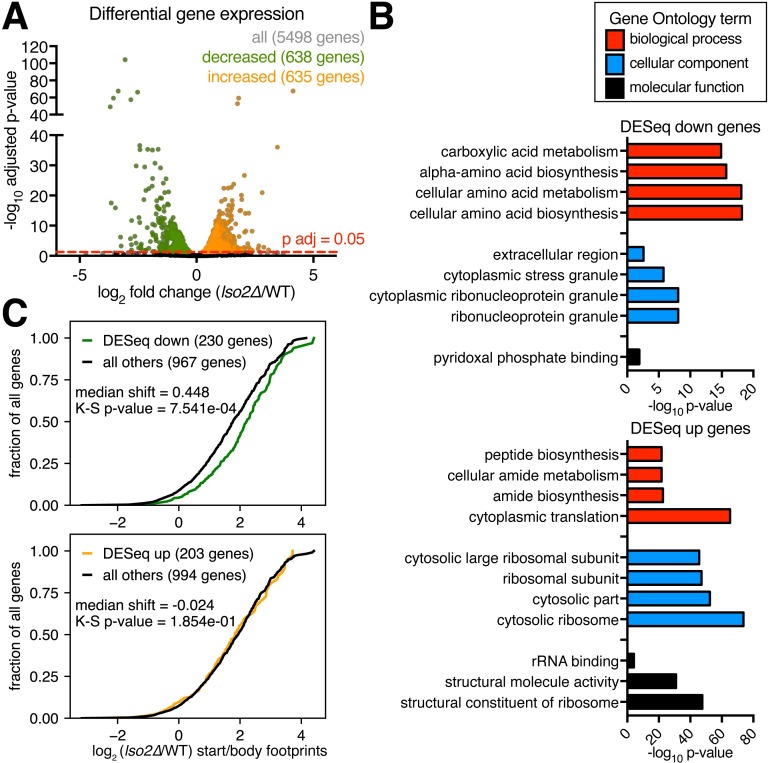
Differential gene expression in lso2Δ correlates with start codon pausing.(A) Benjamini-Hochberg-corrected p-value versus fold change in footprints for lso2Δ versus WT, as determined by DESeq2. Decreased or increased genes with adjusted p-value < 0.05 are highlighted. LSO2 (log2 fold change = −9.61, p-adjusted = 3.00E-18) is omitted for space. (B) Gene Ontology annotations and p-values of enrichment for the DESeq-decreased and DESeq-increased categories, respectively. (C) Empirical cumulative distribution plots of the change in start codon to body read ratio for DESeq-decreased (top) and DESeq-increased (bottom) genes, respectively. Only genes with ≥64 reads were included. See also S6 Fig and S4 Table. K-S, Kolmogorov-Smirnov; rRNA, ribosomal RNA; WT, wild type.